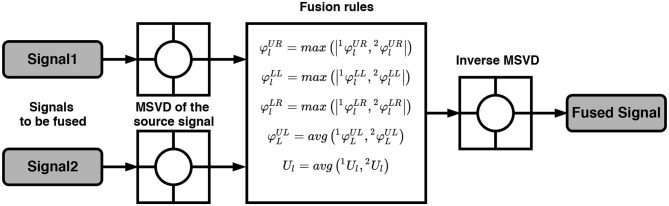
MSVD fusion scheme.